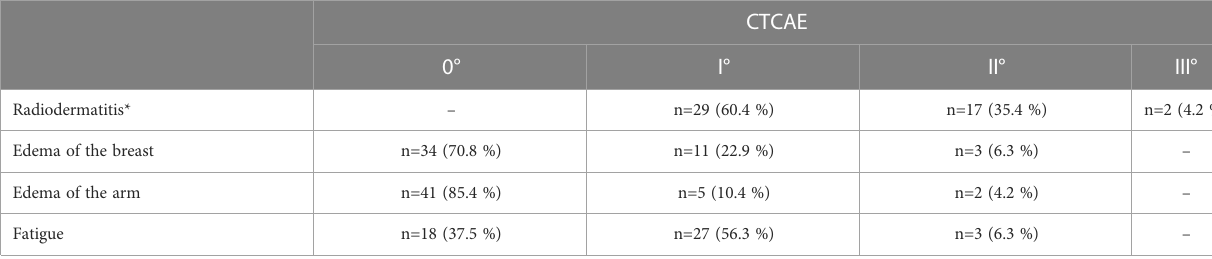
TABLE 1 Summary of acute toxicity (absolute and relative numbers) classi fi ed with